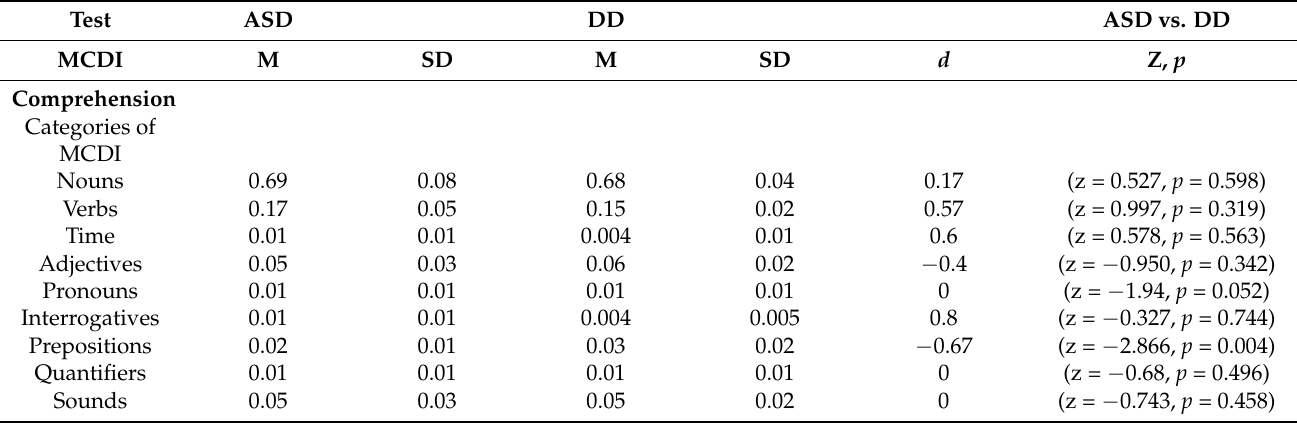
Table 5. Descriptive statistics corresponding to the proportions for each MCDI category with respect to lexical comprehension.